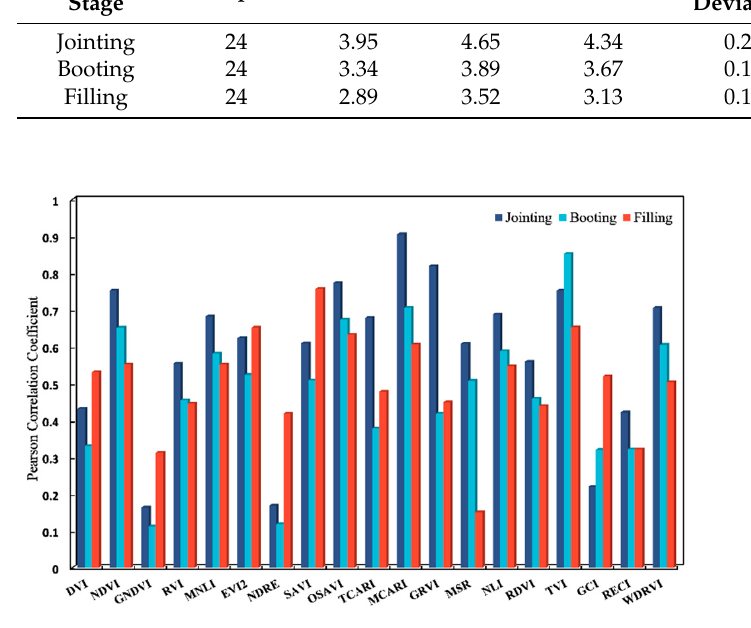
Figure 7. Correlation Coefficient between VIs with LNC based on raw multispectral images at different stages.